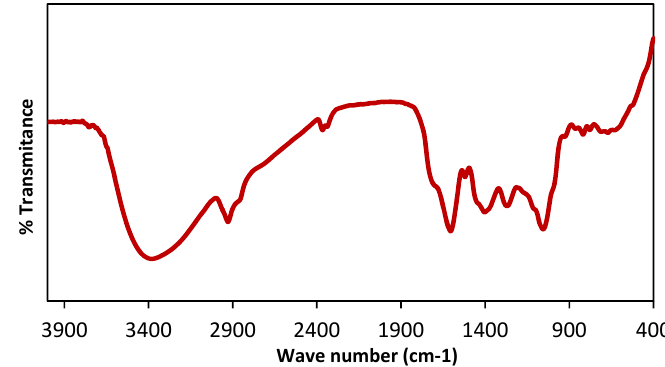
Fig. 6. FT-IR spectrum of Oenothera biennis extract